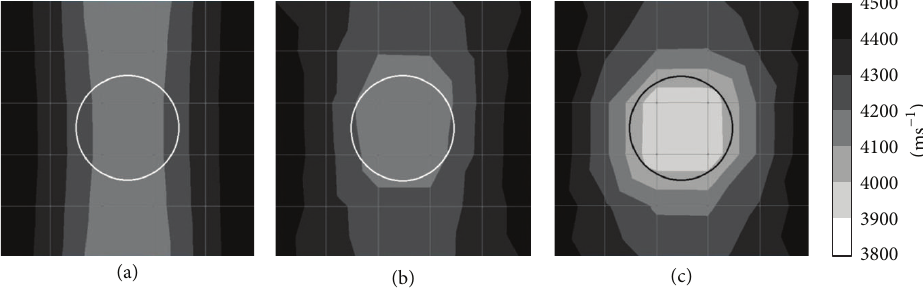
Figure 12: Tomograms simulated by 25 elements: (a) 0% void; (b) 50% void; and (c) 100% void.